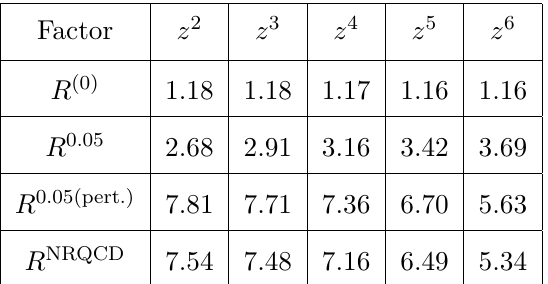
Table 2 . The ratios of moments of fragmentation functions in different approaches defined in eq. (5.30). R (0) represents FF with lowest order in v 2 expansion, R 0 . 05 represents FF with ¯Λ = 0 . 05GeV , R 0 . 05( pert. ) represents perturbative expansion of FF with ¯Λ = 0 . 05GeV and also replacing M H by 2 m Q , and R NRQCD represents FF calculated in NRQCD.